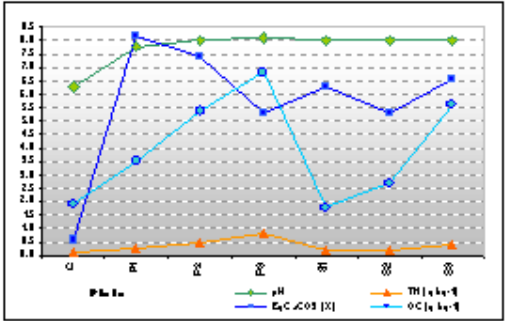
FIGURE 5. pH, equivalent calcium carbonate (EqCaCO 3 ), total nitrogen (TN), and organic carbon (OC) values in samples from the plots after 12 months of amendments addition. C: control; pig manure doses P1-P2-P3; sewage sludge doses